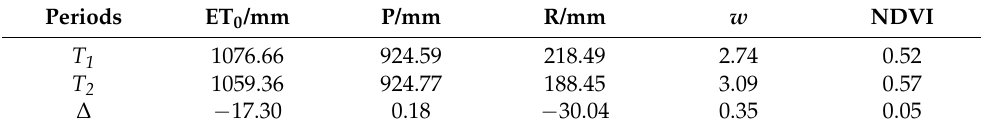
Table 1. The eigenvalues of the climate, hydrology, and NDVI variables in the MUHR. Periods ET 0 /mm P/mm R/mm w NDVI